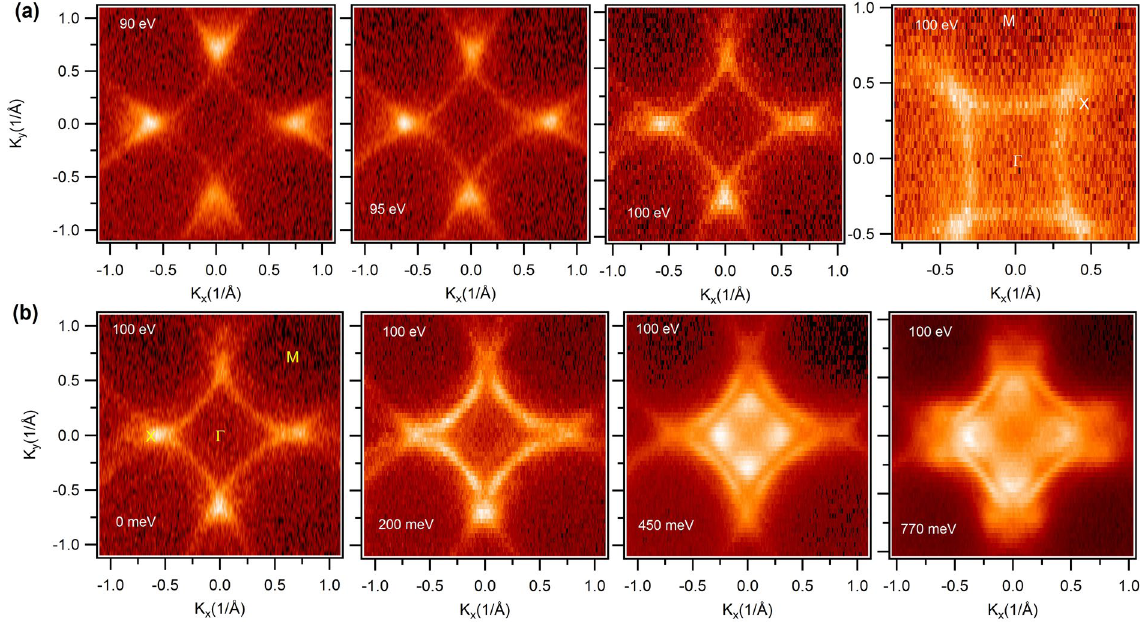
Figure 2. Fermi surface and constant energy contour plots. ( a ) Experimentally measured Fermi surface maps at various photon energies and at different high symmetry directions. The rightmost panel represents the Fermi level in a different orientation with high symmetry points. Photon energies are noted in the plots. ( b ) Constant energy contour plots at various binding energies. Energies are noted in the plots. High symmetry points are indicated in the leftmost plot. All the measurements were performed at the ALS beamline 4.0.3 at a temperature of 21